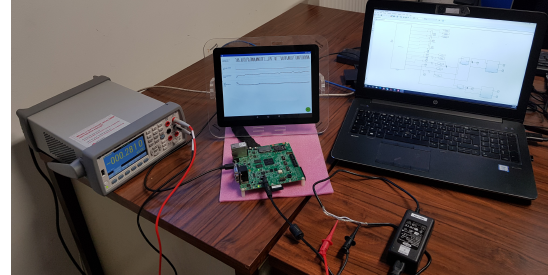
Figure 4. Setup with the development board, its touchscreen, and the ampere meter.